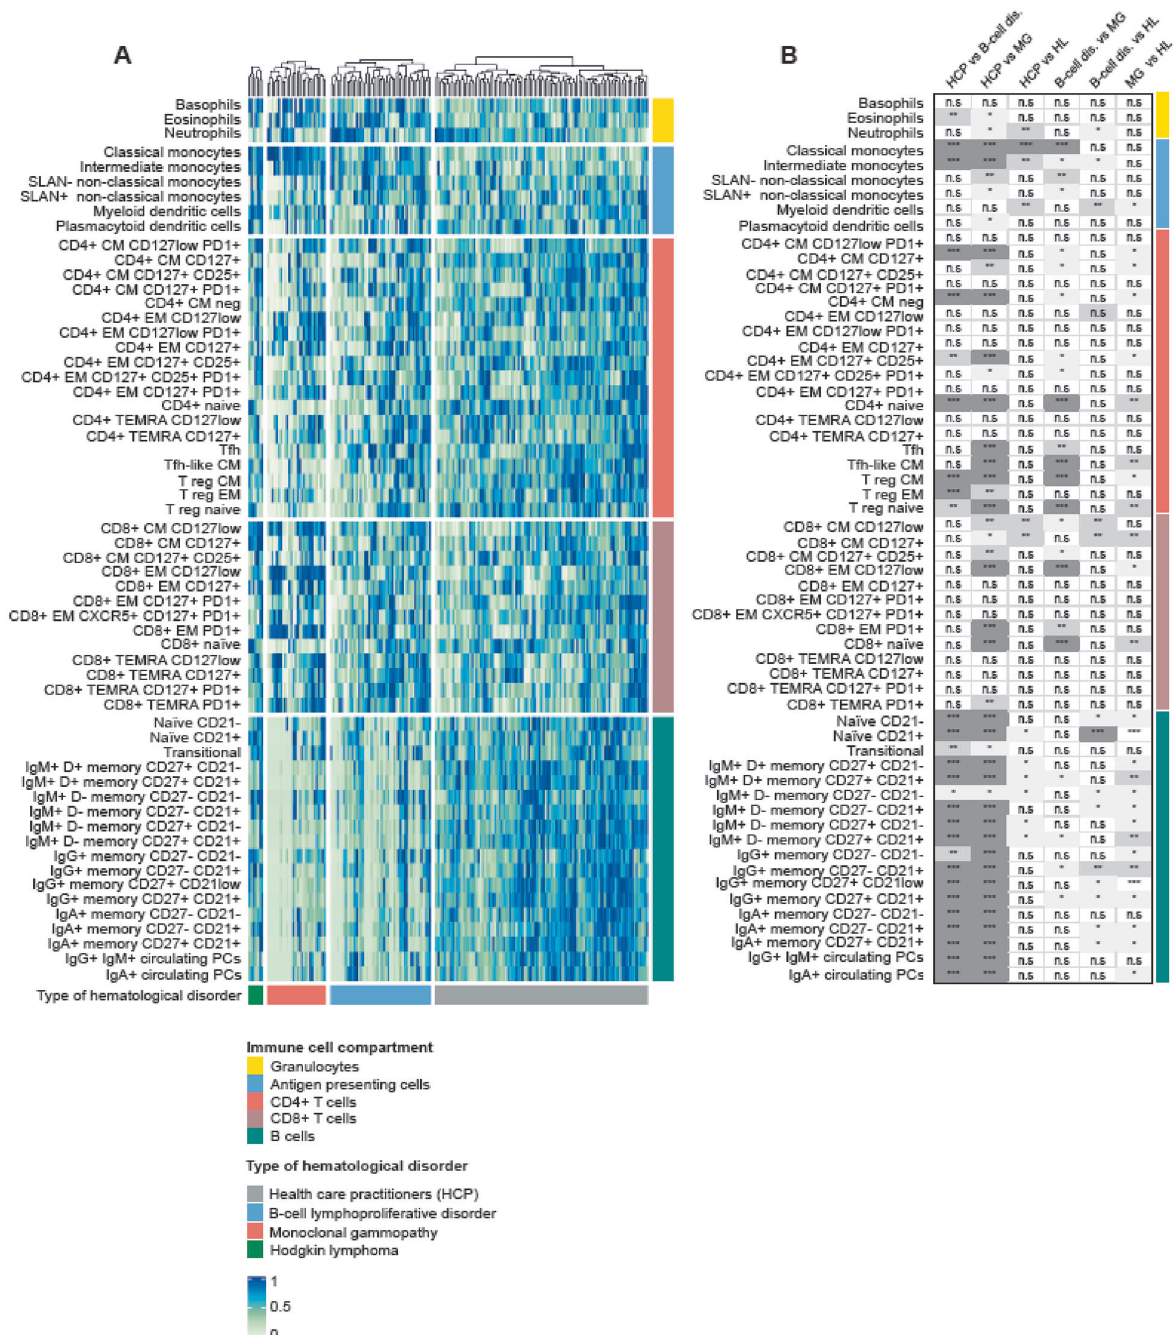
Fig. 2 The immune landscape of hematological patients and HCP. A Supervised clustering of 83 patients with hematological malignancies and 102 health care practitioners (HCP), based on the percentile distribution of 59 immune cell types in peripheral blood that were categorized into fi ve groups: granulocytes, antigen-presenting cells (APC), CD4, and CD8 T cells and B cells. Patients were grouped based on the diagnosis of a B-cell lymphoproliferative disorder (B-cell dis.), monoclonal gammopathies (MG), and Hodgkin lymphoma (HL). B Statistical signi fi cance of differences across groups (with graphical representation of such differences in Supplemental Fig. 2). CM, central memory; EM, effector memory; Treg, T regulatory cells; Tfh, T follicular-like; TEMRA, terminally effector memory CD45RA + ; PC, plasma cells. * P < 0.05; ** P < 0.01; *** P < 0.001; n.s., not signi fi Tumor-related immune dysregulation and therapy-related helper (Tfh) cell types were additionally skewed in those with immunosuppression monoclonal gammopathies. Patients with Hodgkin lymphoma Next, we analyzed the immune status of HCP compared to that of displayed mild deregulation of the B- and T-cell compartments, patients that had never received anticancer therapy (i.e., tumor- and the most signi fi cant alterations were observed in APC. related immune dysregulation), were on-treatment or had Interestingly, a signi fi cant increment of classical and inter- fi nalized their regimen (i.e., therapy-related immunosuppression). mediate monocytes was found across hematological patients.